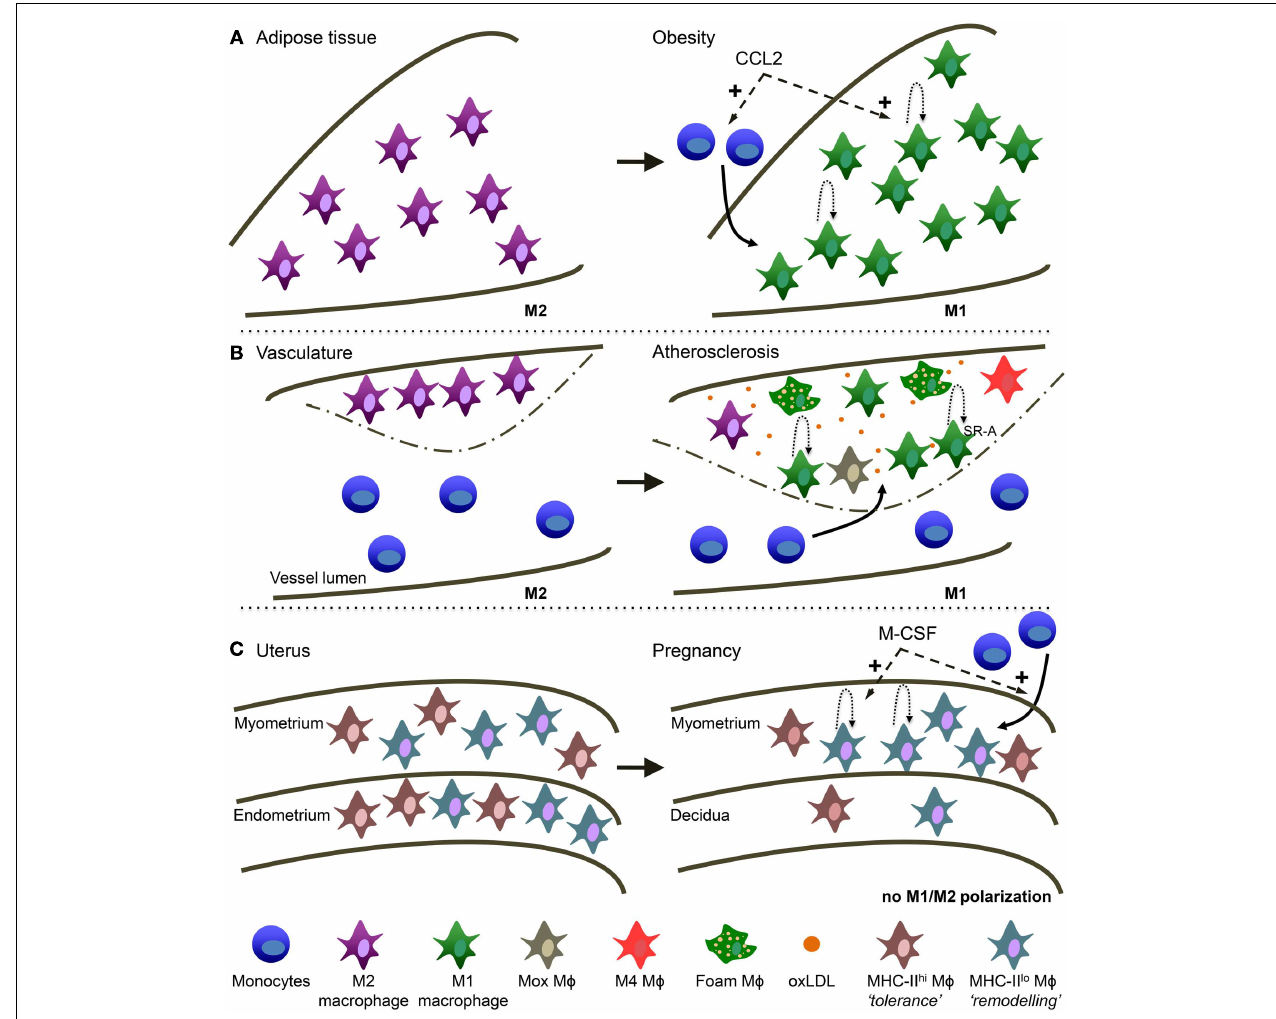
a main trigger of macrophage activation in the lesion. In addition, several other types of macrophages have been described in atherosclerosis: “Mox,” “M4” and the typical foam macrophages. (C) Maternal-fetal interface . In the non-pregnant uterus MHC-II low and MHC-II high macrophages are evenly distributed over the myometrium and endometrium. In the pregnant uterus macrophage numbers decline in the endometrium (now called decidua) and MHC-II low macrophages preferentially accumulate in the myometrium. M-CSF is involved in both the attraction of monocytes as well as macrophage